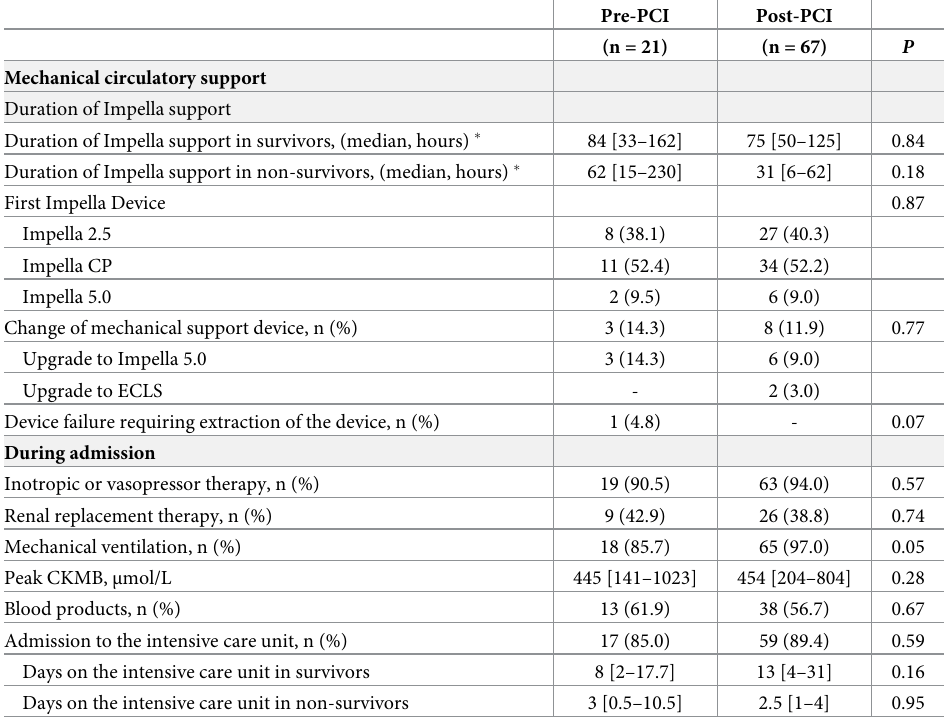
Table 2. Clinical course of AMICS patients treated with primary PCI and